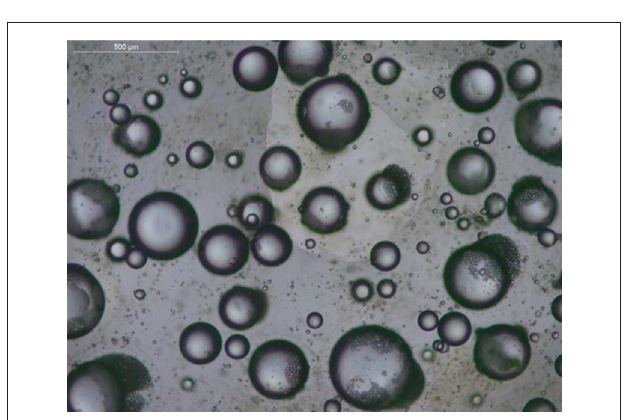
FIGURE 3 | Microscope image of the microcapsules used in this